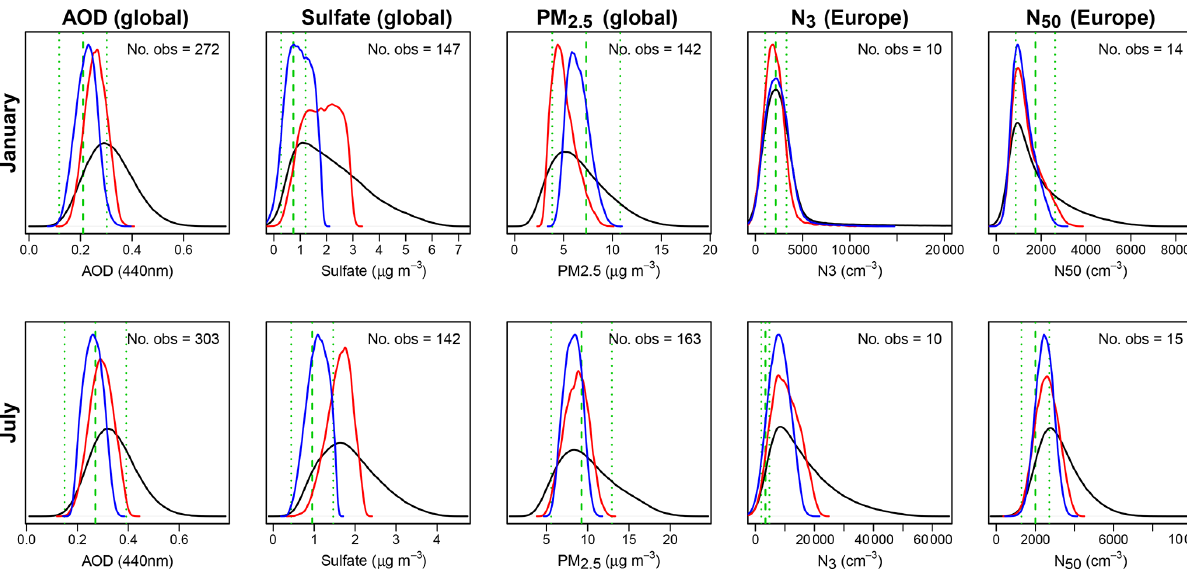
Figure 8. Comparison of the constrained model with the measurements for January (top) and July (bottom). The distributions were calculated as a mean over model grid boxes containing measurements. AOD, sulfate and PM 2 . 5 are global comparisons; N 3 and N 50 are Europe-only comparisons due to the limited global coverage of these measurements in each month. The black line shows the prior (unconstrained) probability distribution of the model. The blue line shows the constrained model distribution when only measurements of each type are used in the constraint. The red line shows the constrained model distribution when all measurement types are used. The green dashed line shows the mean of the measurements and the dotted lines show the approximate 95% uncertainty range on an average observation that was accounted for in the